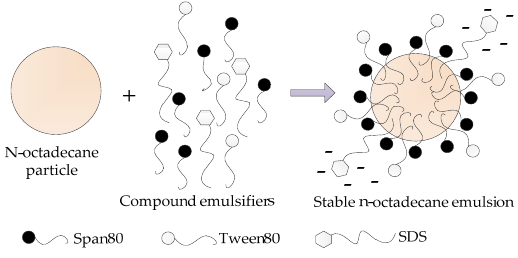
Figure 3. Emulsification mechanism of the compound emulsifiers.